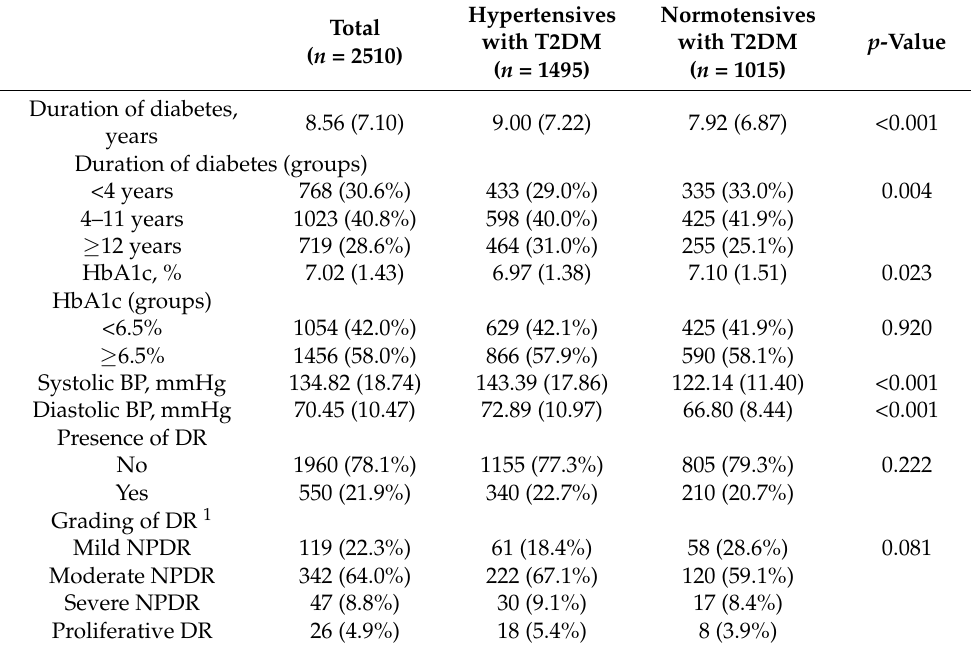
Table 2. Diabetes duration, haemoglobin A1c, blood pressure, and diabetic retinopathy of study